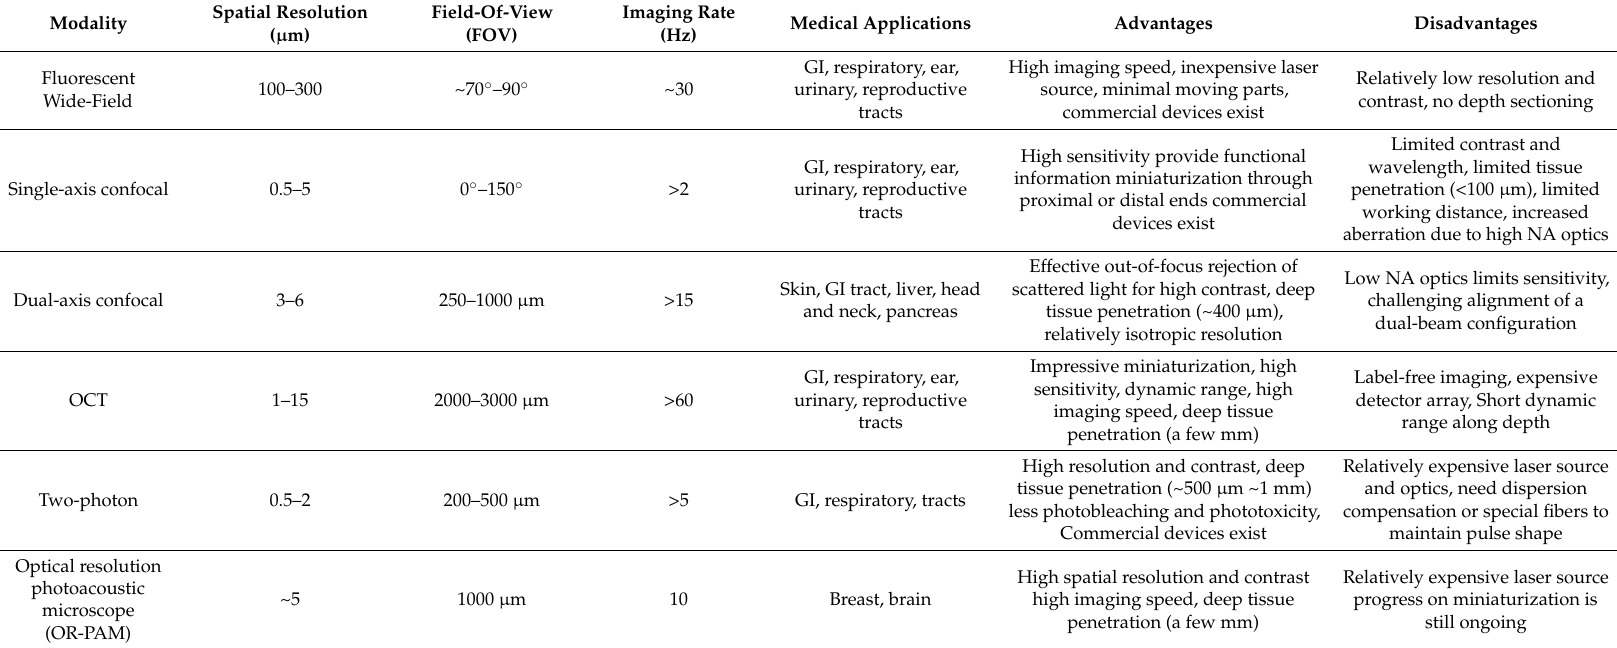
Table 2. Summary of the characteristics for imaging modalities applicable to medical